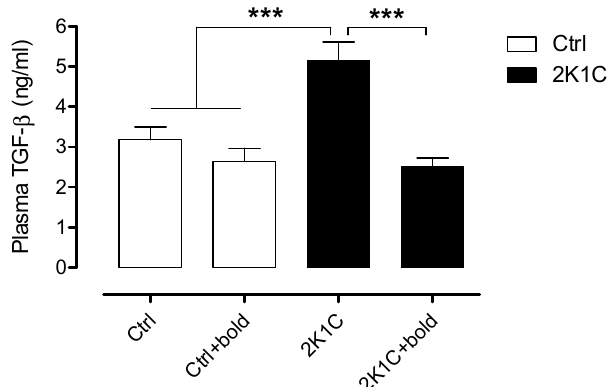
Figure 7. Boldine decreased TGF- β expression in renal tissue of 2K1C hypertensive rats. A TGF- β ELISA assay was performed to determine the TGF- β amounts secreted to plasma under different conditions, six weeks after rats became hypertensive. Bars represent the mean ± SE. The differences were evaluated by analysis of variance followed by the Tukey post-hoc test. *** p < 0.001 vs. 2K1C ( n = 5/all groups).